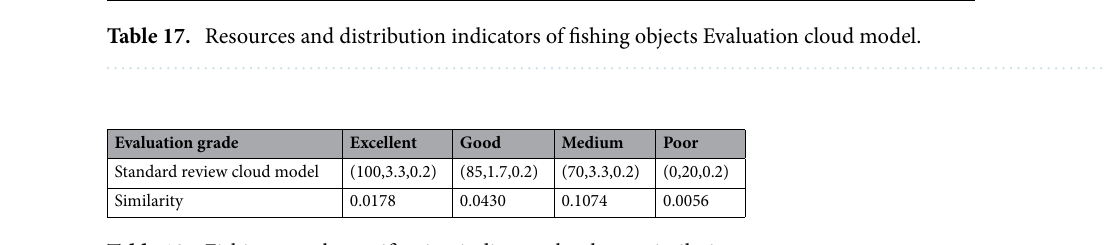
Table 18. Fishing vessels specification indicator cloud map